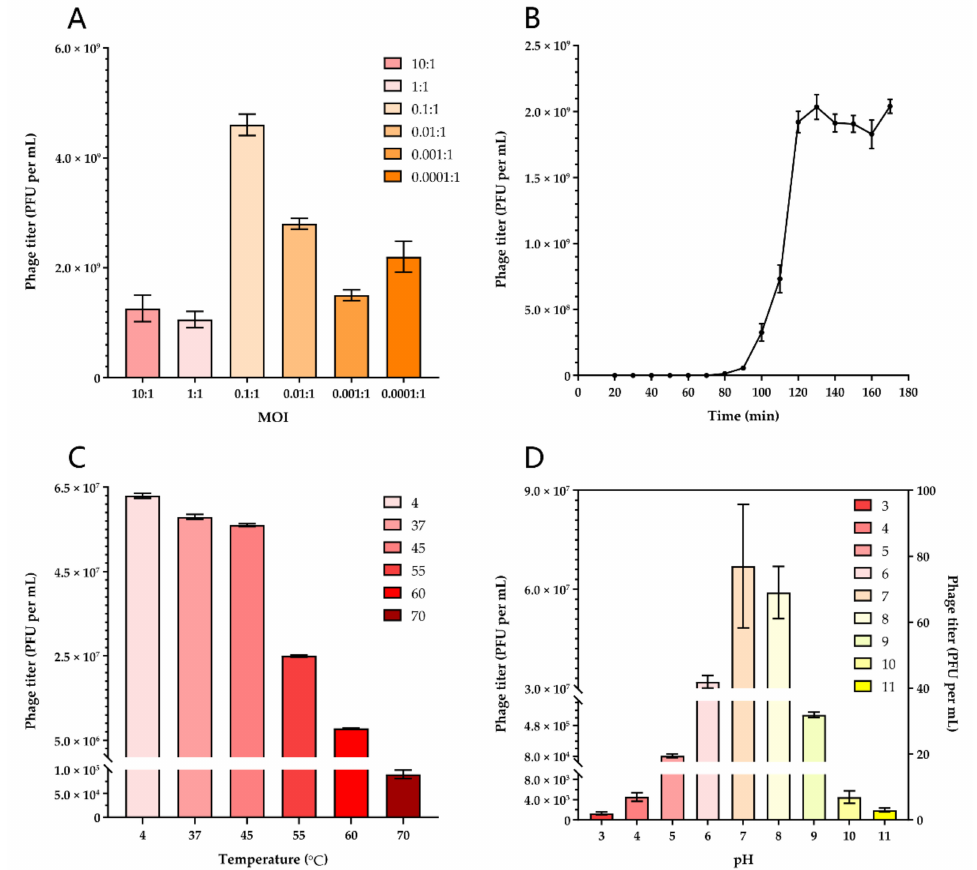
Figure 3. Physiological characteristics of phage AH67C600_Q9. ( A ) Optimal MOI test. The phage AH67C600_Q9 achieved the highest titer after cultured while the MOI is 0.1:1 (4.63 × 10 8 PFU per mL). ( B ) One step curve of phage AH67C600_Q9. After 20 min of early treatment time, 20 to 80 min is the latent time and 80 to 120 min is the burst time. At the plateau phase, the maximum number of progeny was 90 PFU per cell. ( C ) Thermal stability test. The phage AH67C600_Q9 had stable biological activity at temperatures of 4 to 50 ◦ C. ( D ) pH stability test. The phage AH67C600_Q9 is stable at the pH of 6 to 8. Due to the large difference between results, titers for pH = 3, 4, and 11 are listed on the right y -axis and the rest are on the left y